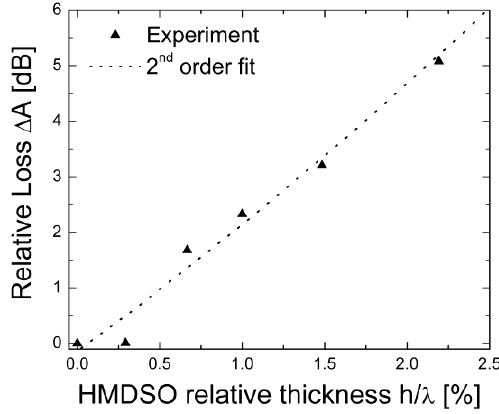
Figure 8. Change in insertion loss of a pp-HMDSO coated FPAR.